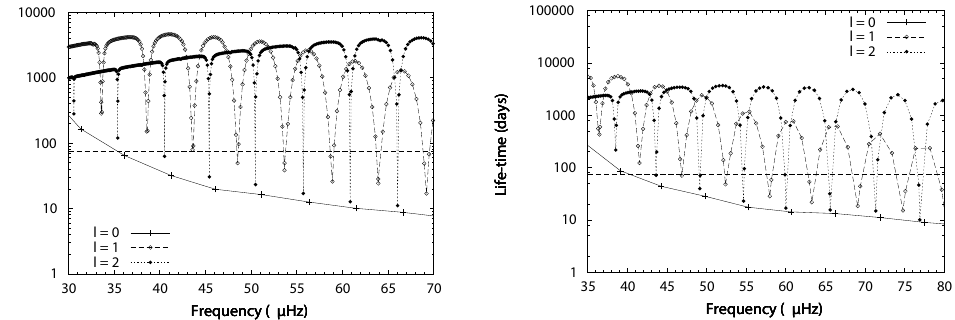
Figure 13: Estimated mode lifetimes for red-giant models. Results are shown for radial modes (pluses connected by solid lines) and for nonradial modes of spherical degree 𝑙 = 1 (open circles connected by dashed lines) and 𝑙 = 2 (filled circles connected by dotted lines). The horizontal dashed line at 75 days indicates the border between unresolved and resolved modes for the CoRoT long run of 𝒯 = 150 days. Left panel: Results for a 2 𝑀 ⊙ red-giant model located approximately half-way up the ascending red-giant branch in the Hertzsprung–Russell diagram, i.e., in the phase of hydrogen-shell burning. Right panel: Results for a 3 𝑀 ⊙ red-giant model in the phase of central-helium burning. Image reproduced with permission from Dupret et al. (2009), copyright by